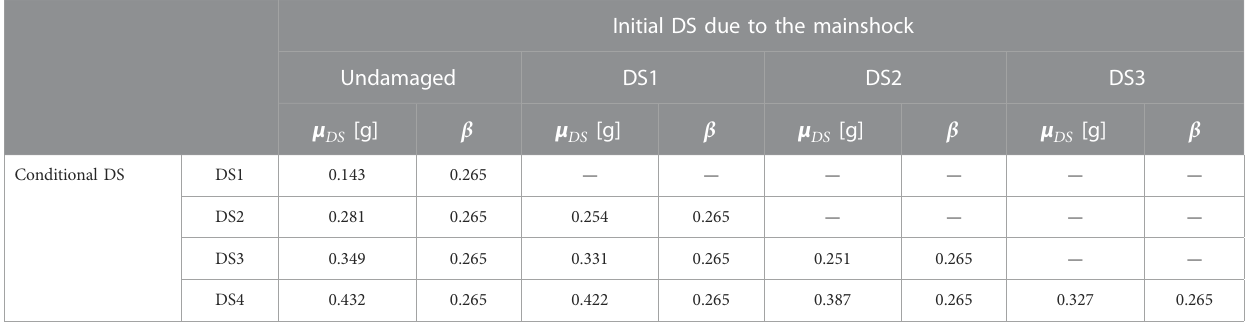
TABLE 2 Median and standard deviation values of state-dependent fragility